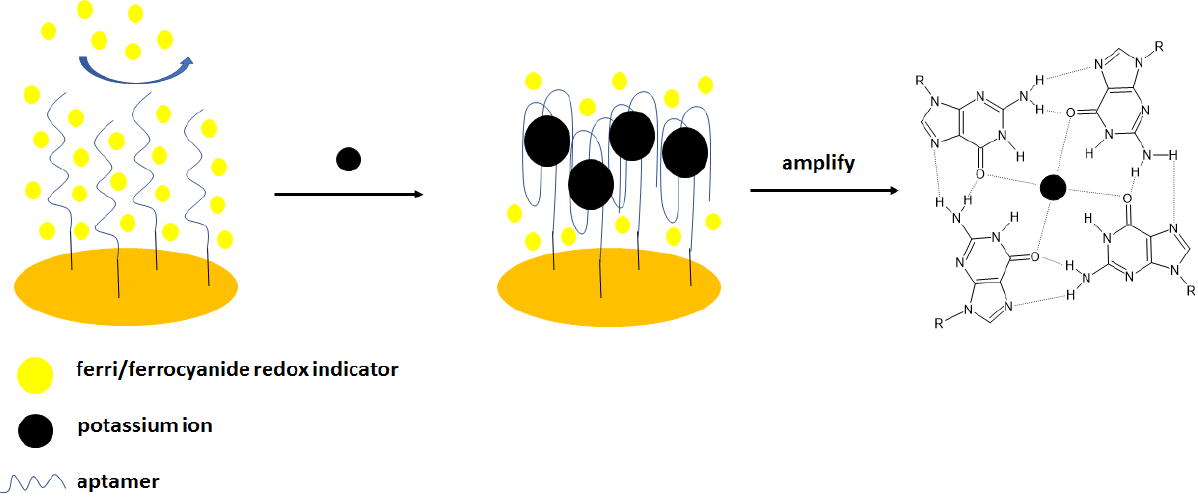
Figure 2. The sensing principle scheme of the impedimetric aptasensor with ferri/ferrocyanide re- dox couple. redox